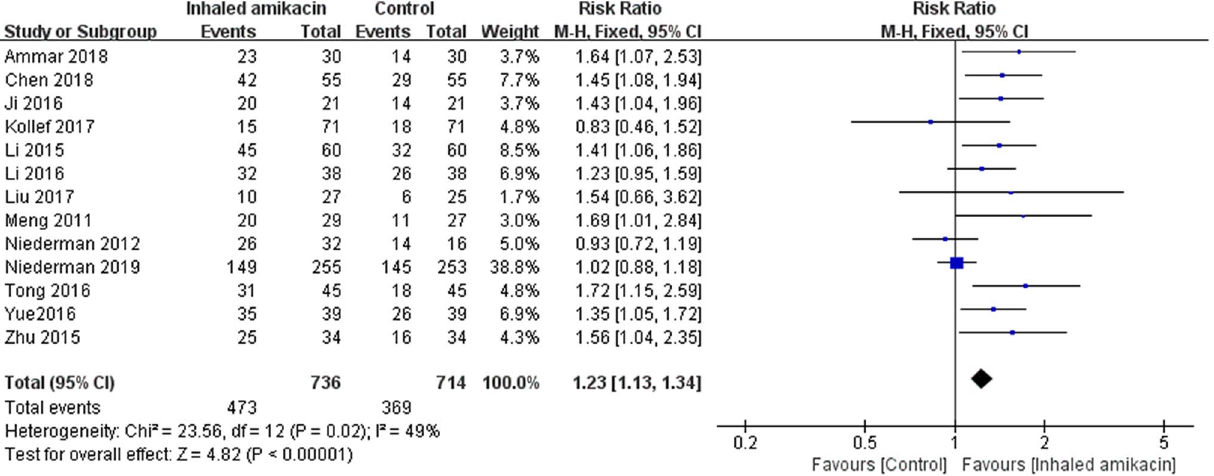
Figure 2. Forest plots of the effects of aerosolized amikacin on clinical